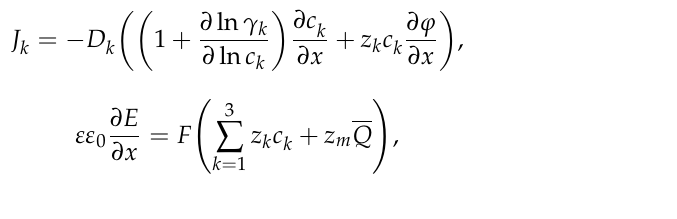
Figure 1. Schematic representation of the simulated system, including an ion-exchange membrane of thickness d (3) and two DBLs (2 and 4) of the thickness δ I and δ II , respectively. Zones (1) and (5) are the bulk solution. The typical concentration profiles are given in the case of CC mode: for ion k in the diffusion layers (k = Na + , Ca 2+ or Cl − ), and for all three ions in the membrane. Ion transfer in the system is described by the Nernst–Planck and Poisson equation, as well as the material balance equation (the continuity equation of matter conservation):